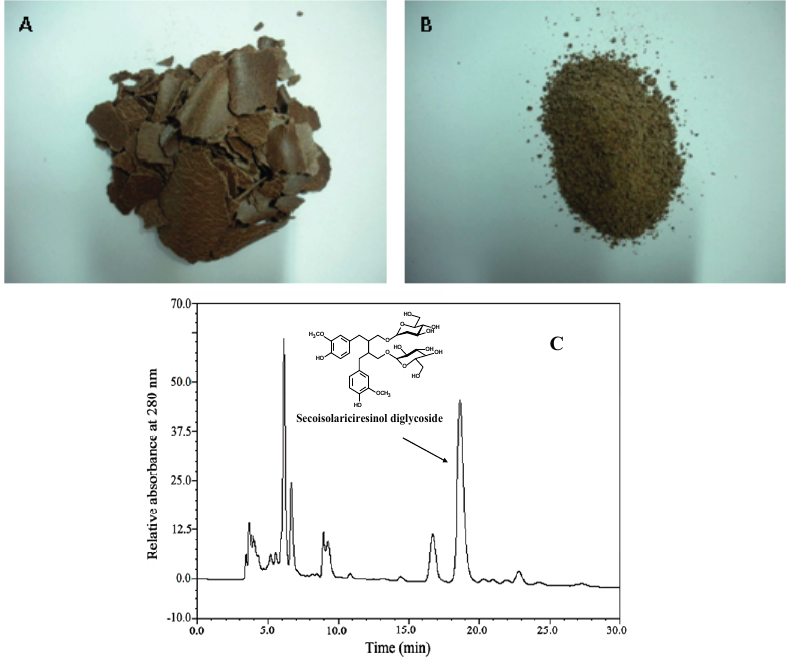
Figure 2. ( A ) The intact flaxseed cakes; ( B ) the crushed flaxseed cakes; ( C ) HPLC chromatograms of flaxseed cake extract at 280